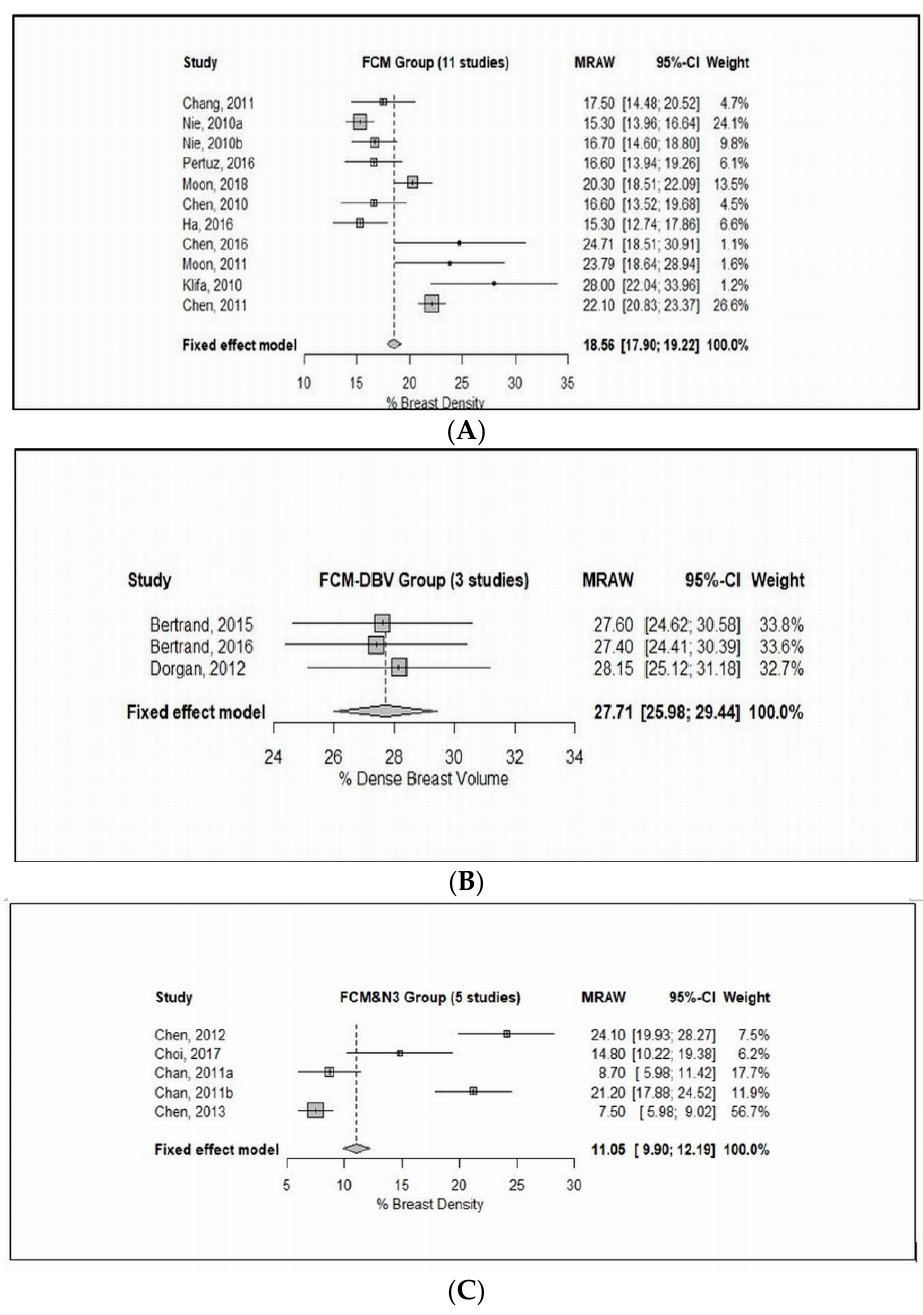
Figure 3. Cont. Figure 3.